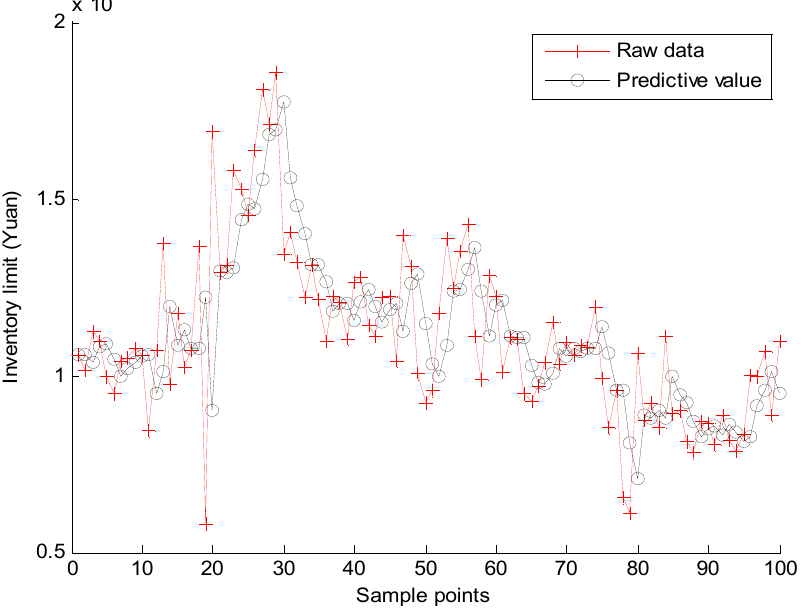
Figure 7. Predictive results of the first exponential smoothing prediction method in